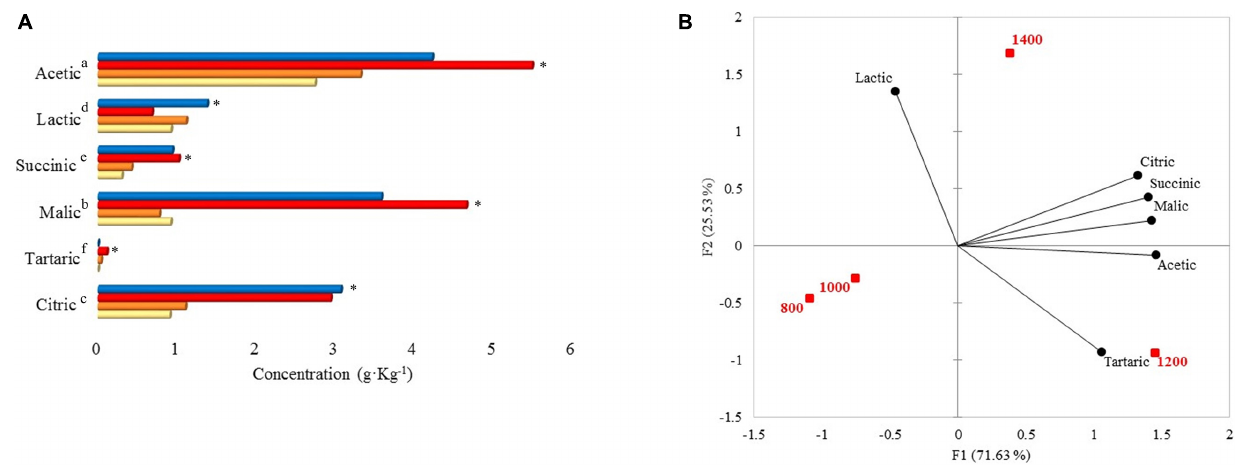
FIGURE 3 | (A) Organic acid concentrations at 48 h of fermentation on different altitudes. Each bar represents an altitude: (cid:4) 800, (cid:4) 1,000, (cid:4) 1,200, and (cid:4) 1,400 m. Significant values ( p ≤ 0.05) are represented in letters, from the highest amount to the lowest. ∗ Altitude that was statistically significant ( p ≤ 0.05) and higher in contrast to the other altitudes. Citric, tartaric, malic, succinic, lactic, and acetic standard deviations: 800 m (0.19, not detected, 0.09, 0.01, 0.43, 0.44), 1,000 m (0.46, 0, 0.37, 0.10, 0.73, 1.57), 1,200 m (1.52, 0, 0.87, 0.41, 0.17, 1.95), 1,400 m (2.55, not detected, 1.97, 0.65, 1.11, 1.65). (B) Principal component analysis (PCA) plot of organic acids and